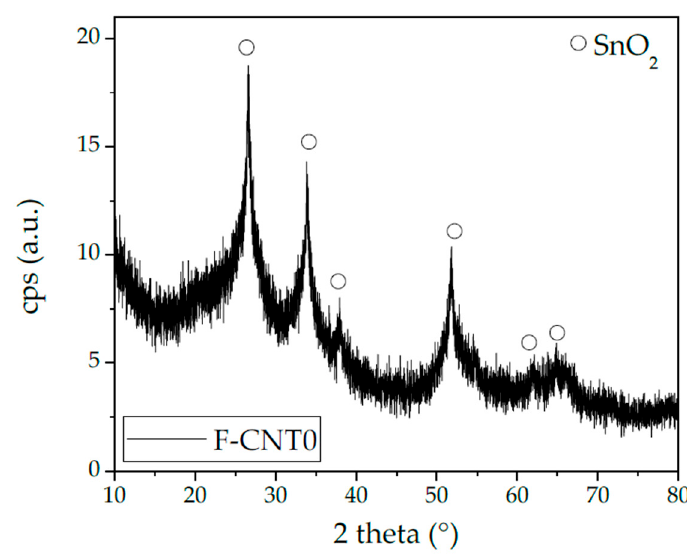
Figure 5. XRD analysis of F-CNT0 TGA (thermos gravimetric analysis) residue.